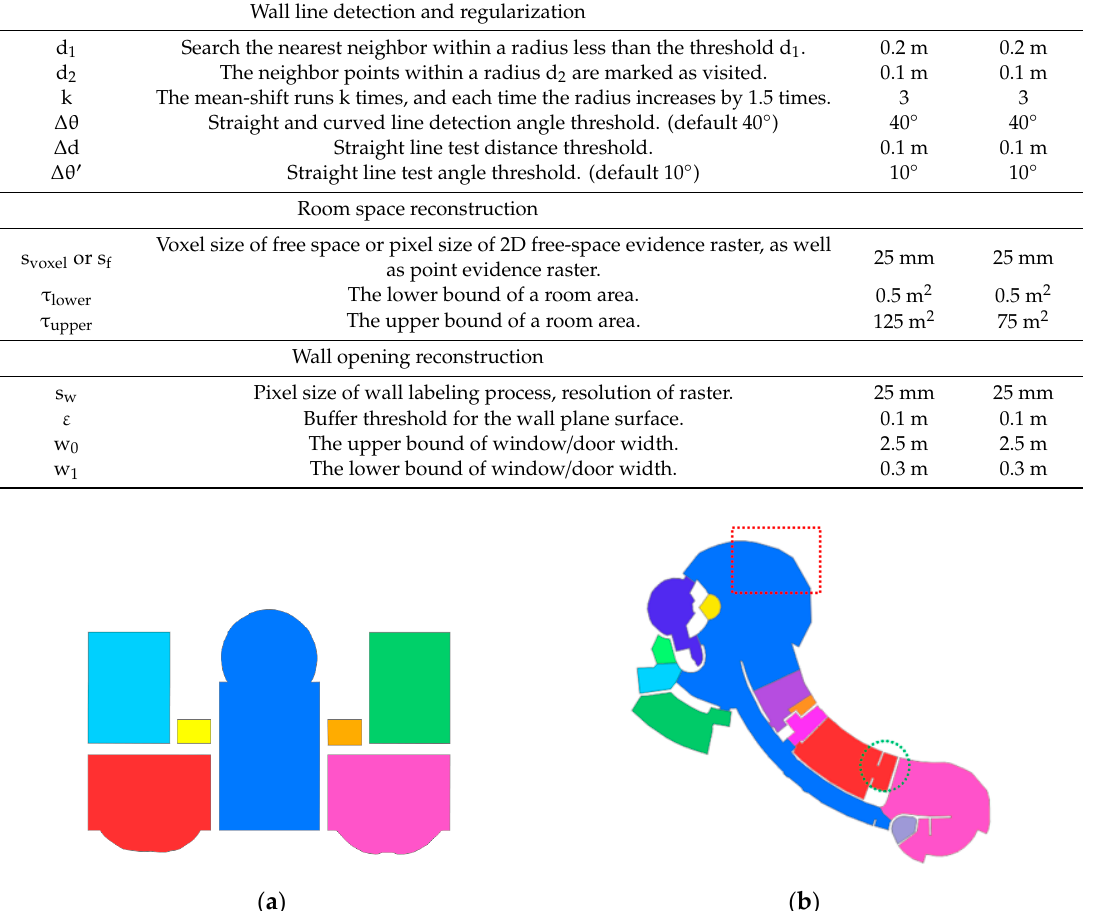
Figure 13. ( a ) Semantic decomposition of the room space and the generated floor plan for dataset-1; ( b ) semantic decomposition of the room space and the generated floor plan for dataset-2. Piecewise straight lines were used to approximate the curved line; the generated room boundary in red box was unsmooth.